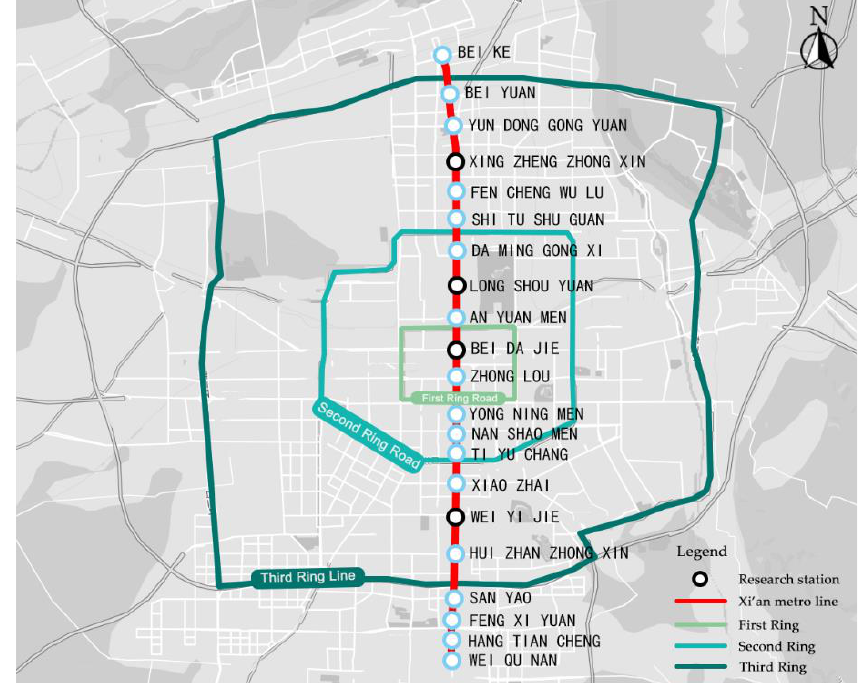
Figure 2. The location of four research stations on Xi ’ an Metro Line 2. Table 2. Classification results of four station types.